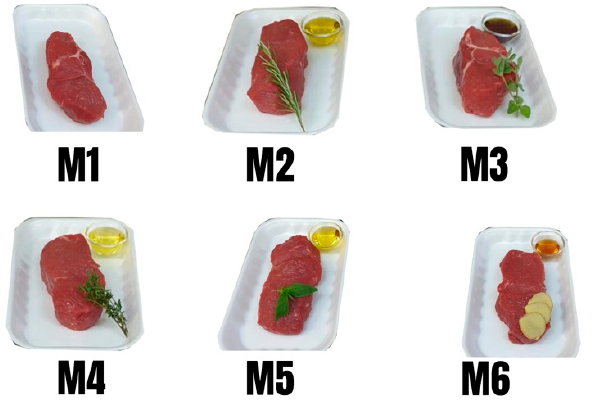
Figure 1. Samples before the marination